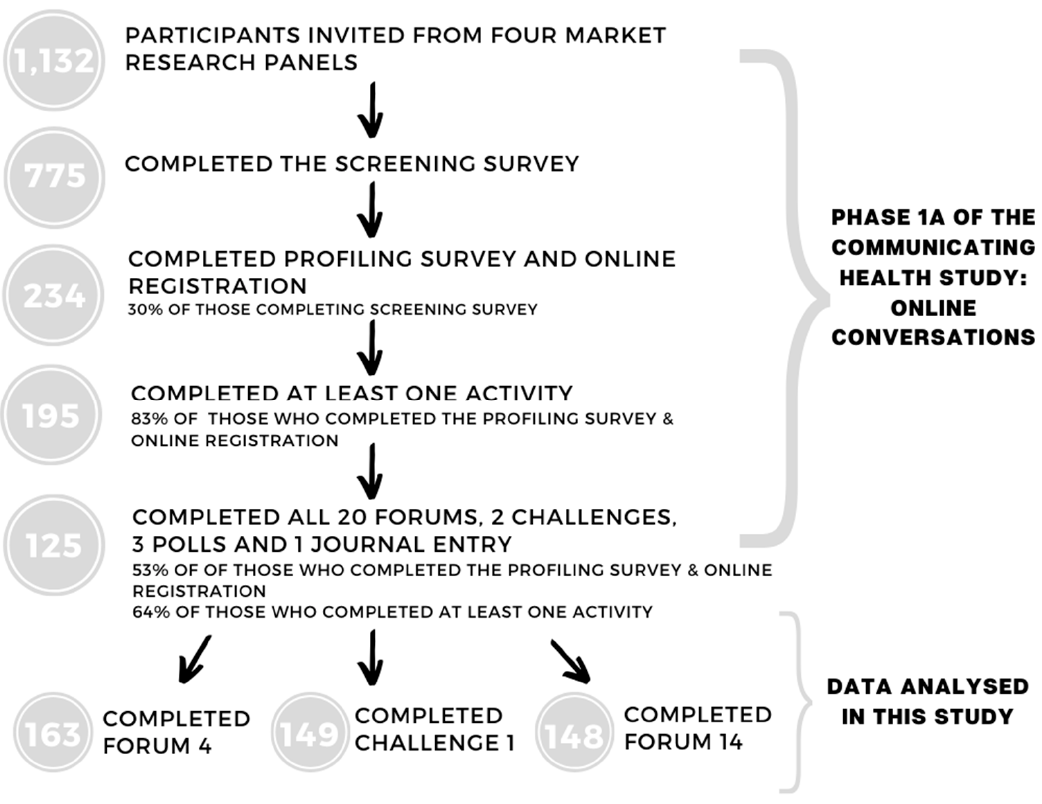
Figure 1. Study flow diagram.